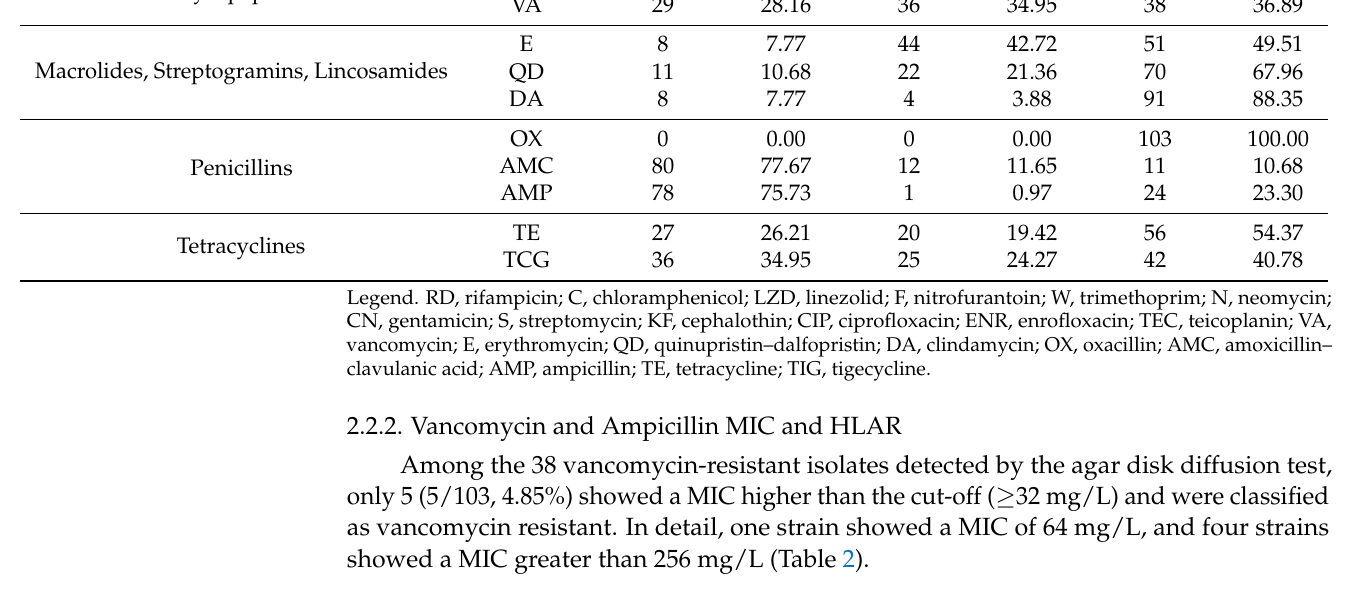
Table 2. Antibiotic resistance of the analyzed Enterococcus isolates in relation to bird provenience and category and to bacterial